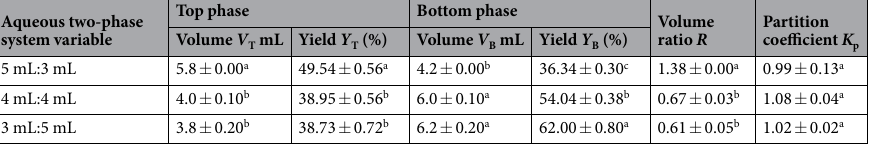
Table 2. Effect of the ratio of the volumes of UCON and KH 2 PO 4 on the separation of peptides. 1 The data (mean ± standard deviation) derived from 3 replicates as described in the Materials and Methods section. 2 The difference between the mean values with the same superscript letter in the same column was significant at a 95% confidence